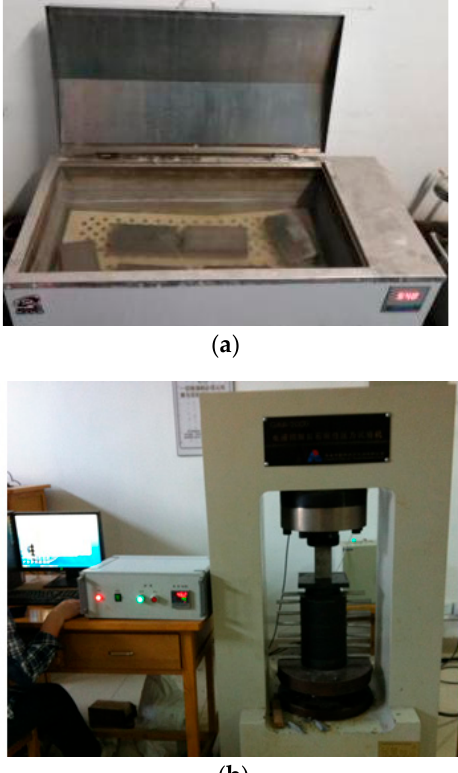
Figure 2. Preparation of rock-like specimen with ( a ) the Curing box and ( b ) the GAW-2000 rigid testing machine.